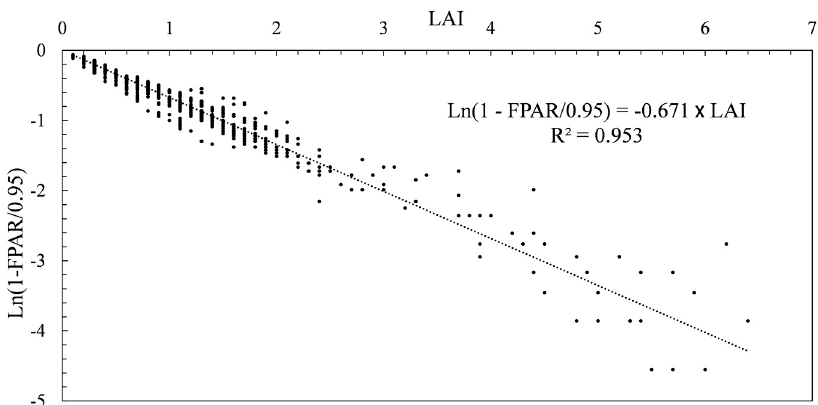
Figure 6. Relationship between LAI and FPAR for points extracted from Evergreen Broadleaf Forests (EBF) land cover type, where the slope of the regression line represents the light extinction coefficient ( k ).